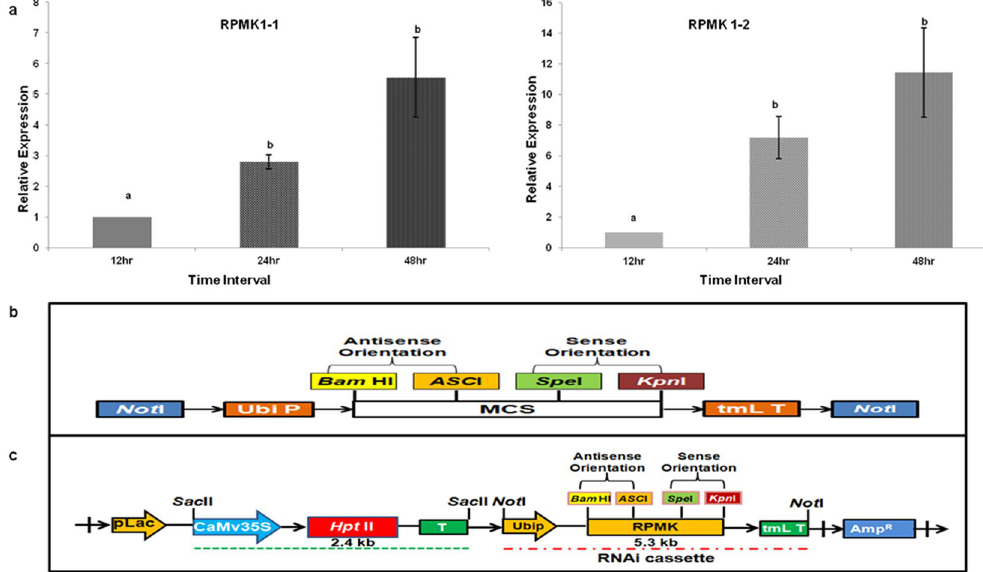
Figure 1. Expression analysis of RPMK1-1 and RPMK1-2 and schematic representation of HD-RNAi gene constructs. ( a ) Total RNA was isolated from plant tissue infected with R. solani 12, 24 and 48 hours post infection (hpi) and used for cDNA synthesis. Quantitative real time PCR was performed using gene-specific primers for RPMK1-1 and RPMK1-2 . R. solani beta tubulin levels were used for normalization purposes. For each gene, the relative mRNA levels at 12 hpi was given the arbitrary value of one and the remaining mRNA levels referred to it. Error bars indicate standard errors. (p = 0.05; ANOVA; with Tukey Kramer Multiple Comparison); ( b ) Partial map of the HD-RNAi construct where ~500 bp cDNA fragments for RPMK1-1 and RPMK1-2 were fused and cloned in sense and antisense orientation in the pSTARLING vector; ( c ) Sub-cloning of the RNAi cassette into a modified pBS vector containing the selectable marker gene hpt